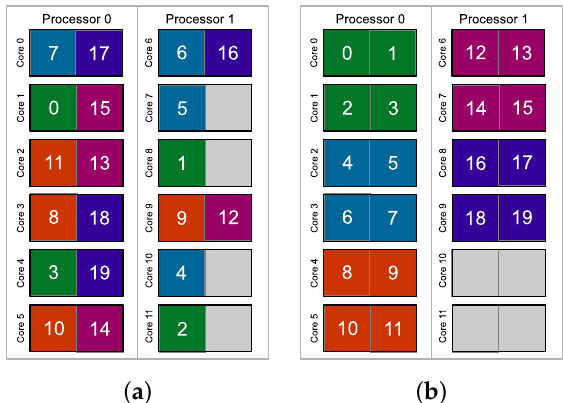
Figure 12. Optimal thread placement. ( a ) Example of thread group placement without control. ( b ) Example of thread group placement with affinity